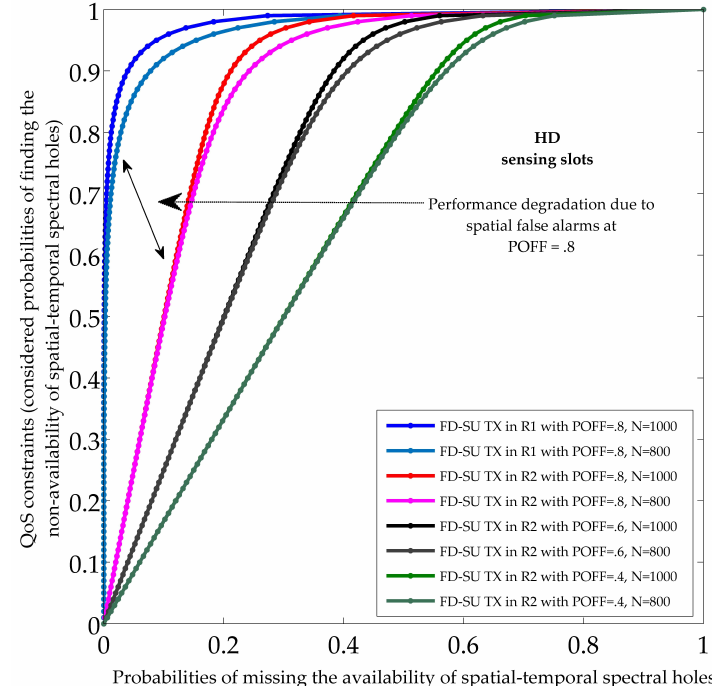
Figure 6. Sensing performance of spatial–temporal spectral holes during the half duplex (HD) sensing slots.